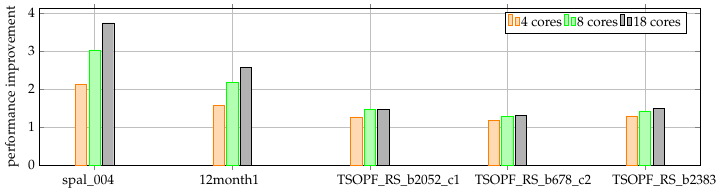
Figure 8. Example loop to parallelize. This loop performs symmetric scaling of a sparse matrix A by a scaling factor s , where s is a diagonal vector. The outer loop can be parallelized if array Ap is monotonically increasing.